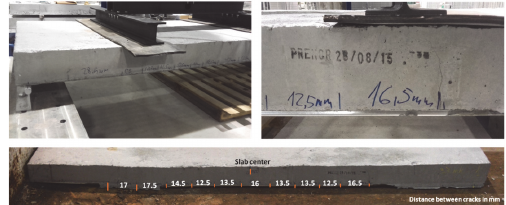
Figure 9: Composite slab LWC LSDur-37, 2610 mm long after m - k test.